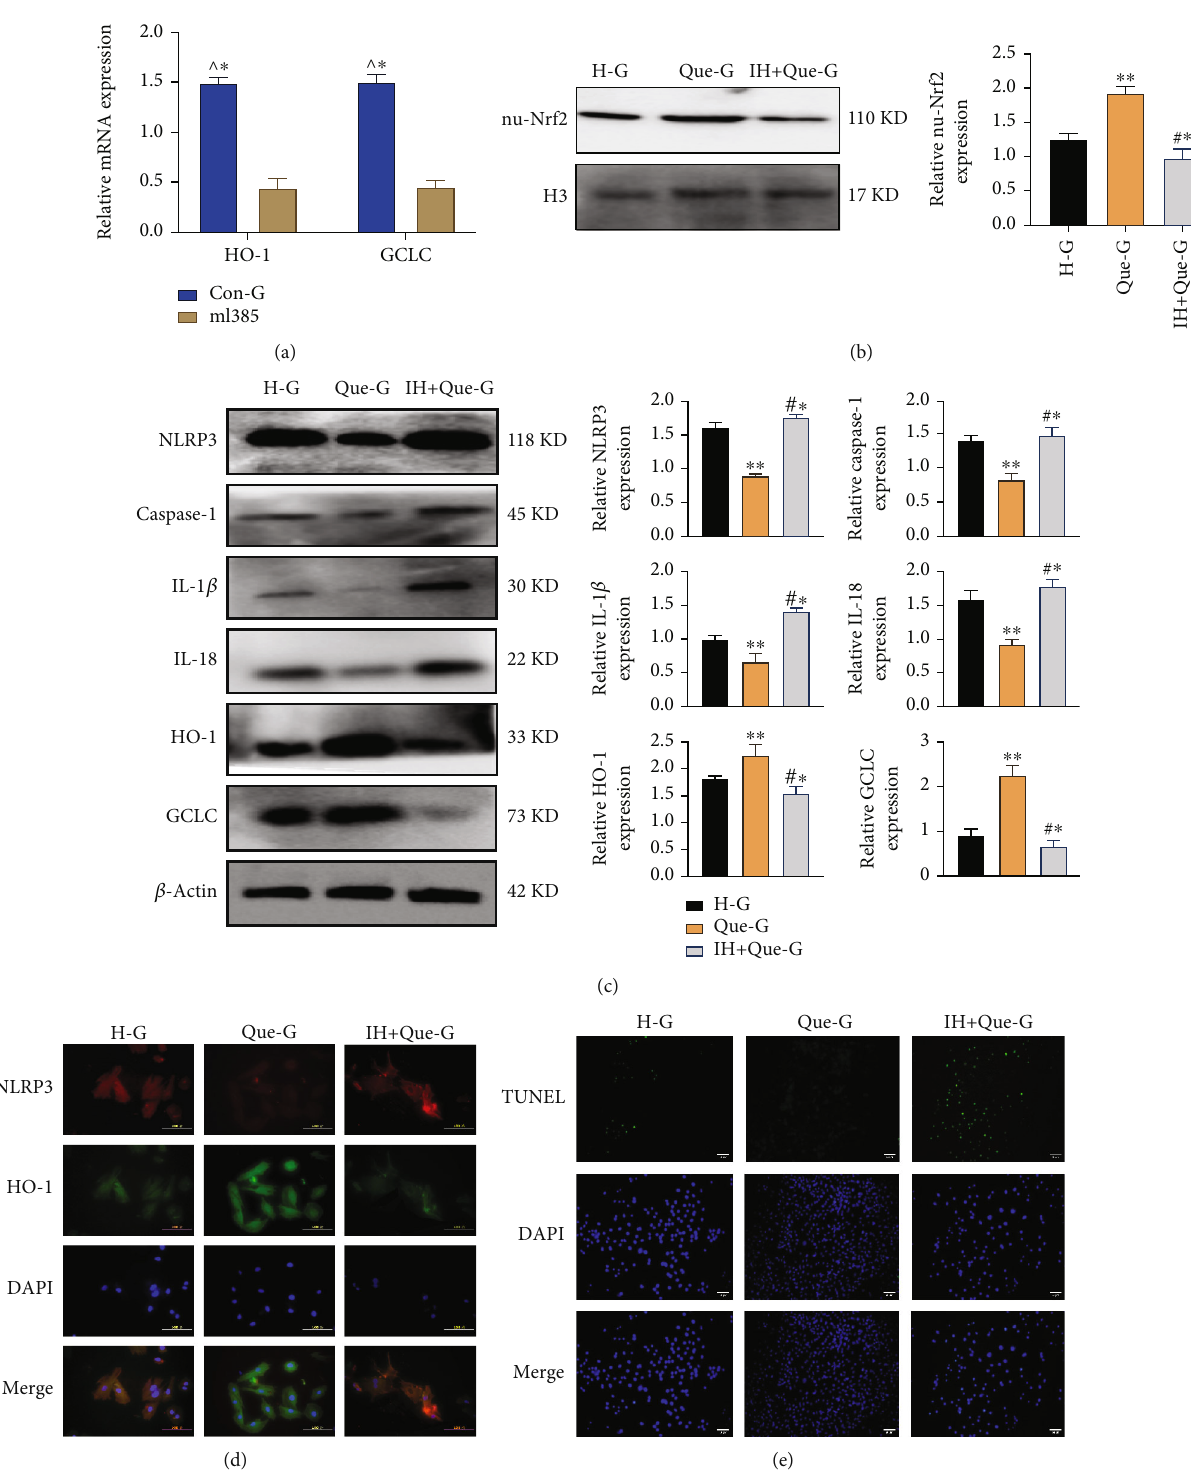
Figure 4: ML385 inhibits the nuclear translocation of Nrf2. (a) mRNA expression levels of HO-1 and GCLC detected by PCR. (b) Expression of Nrf2 in the nucleus detected by WB. (c) Expression levels of pyroptosis pathway-related proteins detected by WB. (d) Expression of NLRP3 and HO-1 in cells detected by immuno fl uorescence ( 200 × ). (e) A TUNEL fl uorescent probe was used to detect the incidence of apoptosis in each group ( 200 × ). H-G: glucose concentration of 30mmol/L; Que-G: glucose concentration of 30 mmol/L +quercetin; IH+Que-G: glucose concentration of 30mmol/L+quercetin+ML385. Data are expressed as the mean ± SD . ^ ∗ P < 0 : 001 , Con- G vs. ML385. ∗∗ P < 0 : 001 , Que-G vs. H-G and IH+Que-G. # ∗ P < 0 : 001 , IH+Que-G vs.